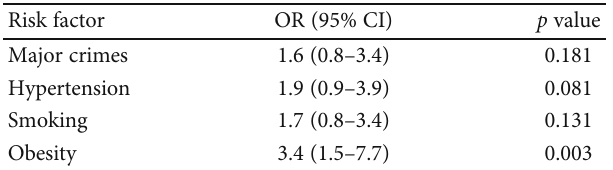
Table 2: Risk factors associated with hypertension in multivariate